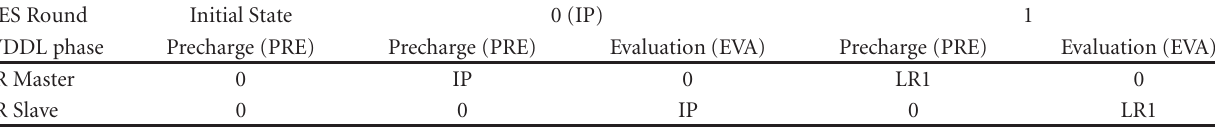
Table 1: Sequence at the beginning of the encryption.